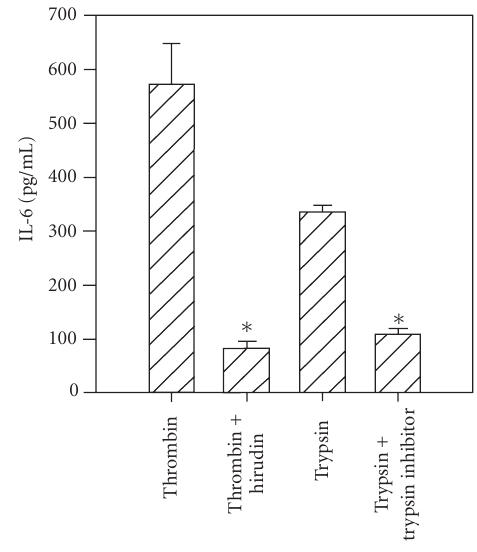
Figure 4: Requirement of the enzymic activity of thrombin and trypsin for HCEC activation . HCEC monolayers were incubated with thrombin (220 nM), thrombin+hirudin (4U/mL), trypsin, or trypsin + soybean trypsin inhibitor (STI) (100 U/mL) for 24 hours at 37 ◦ C. Unactivated cells produced 107 ± 12pg/mL of IL-6. The presence of hirudin or STI to unstimulated cells did not alter IL-6 production. The results presented are representatives of two inde- pendent experiments. ∗ indicates P < .05 when compared to medium control.